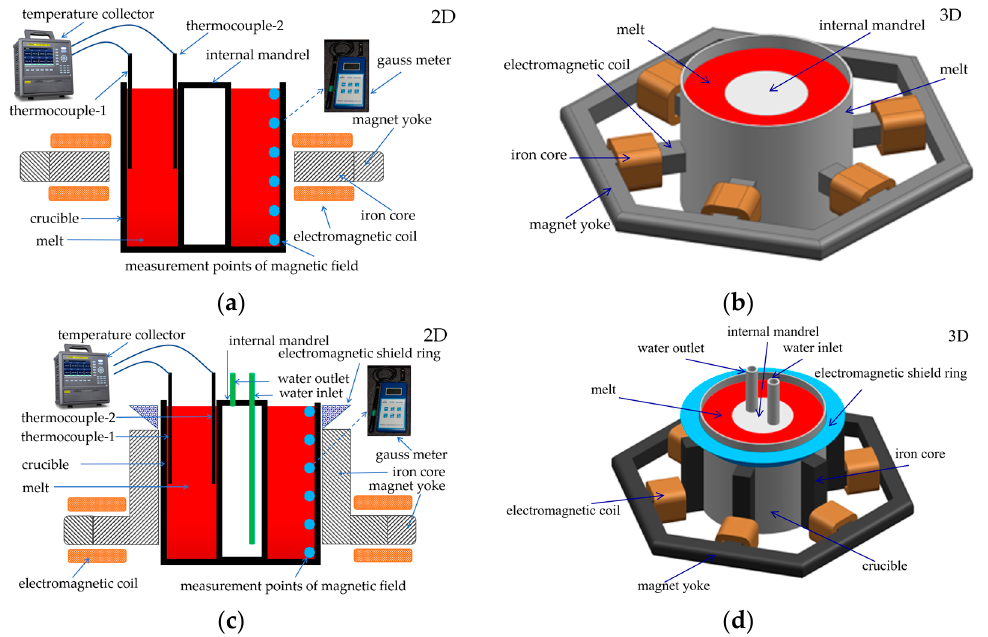
Figure 1. Two-dimensional and three-dimensional geometry models of AEMS and M-AEMS created Figure 1. Two ‐ dimensional and three ‐ dimensional geometry models of AEMS and M ‐ AEMS created by using UG: ( a ) 2D of AEMS; ( b ) 3D of AEMS; ( c ) 2D of M-AEMS; ( d ) 3D of by using UG: ( a ) 2D of AEMS; ( b ) 3D of AEMS; ( c ) 2D of M ‐ AEMS; ( d ) 3D of M ‐ AEMS.